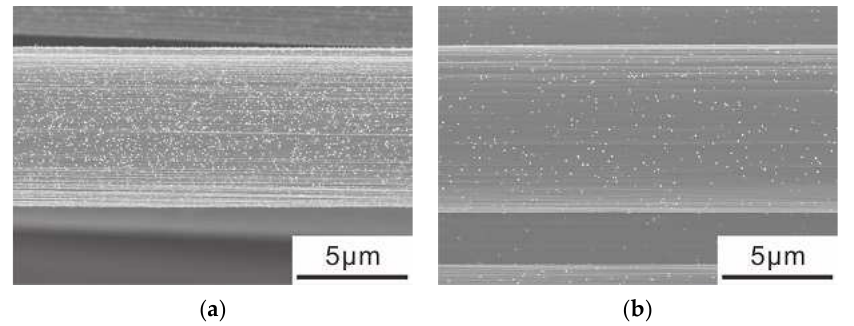
Figure 4. FE-SEM images of ( a ) D-Ni-CF ( I = 200 mA, J = 3.79 A/m 2 , t = 5 s) and ( b ) P-Ni-CF ( I = 200 mA, J = 3.79 A/m 2 , t ON = 10 ms, t OFF = 100 ms, t = 5 s).